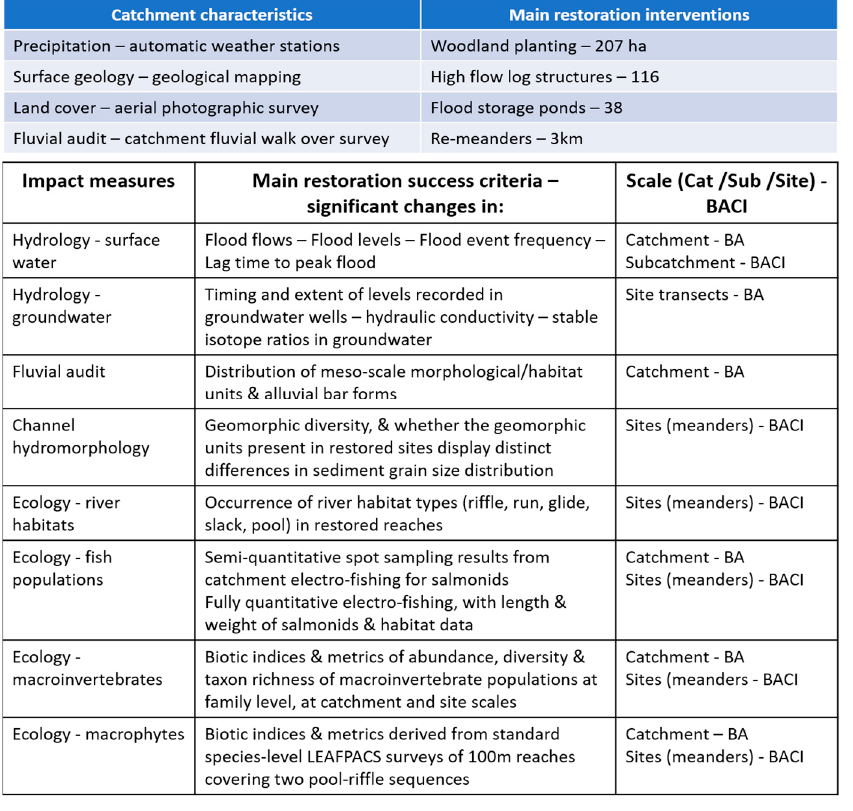
Figure 3. Eddleston Water restoration monitoring success criteria.